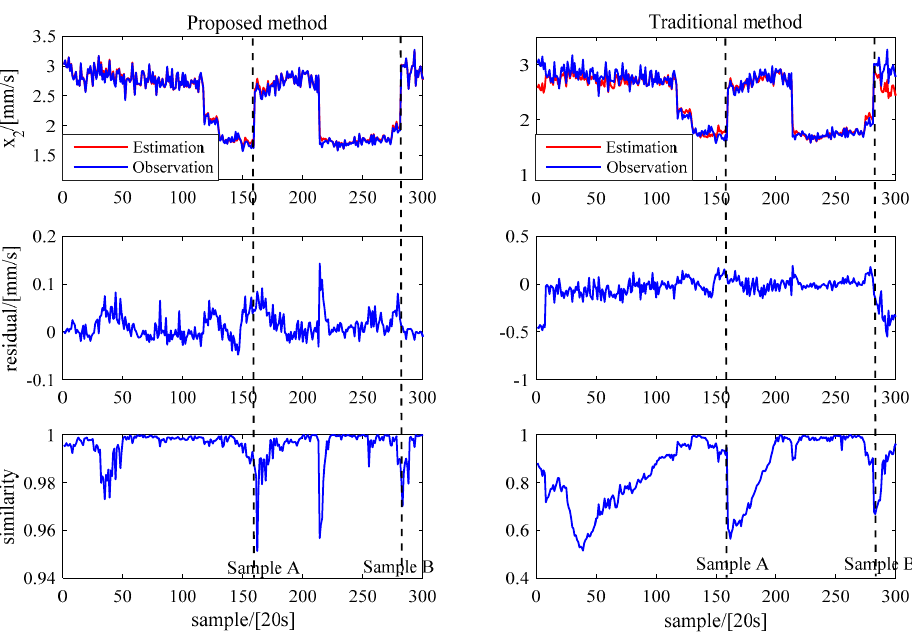
Figure 8. Comparison for proposed method and traditional method for vertical vibration condition II.